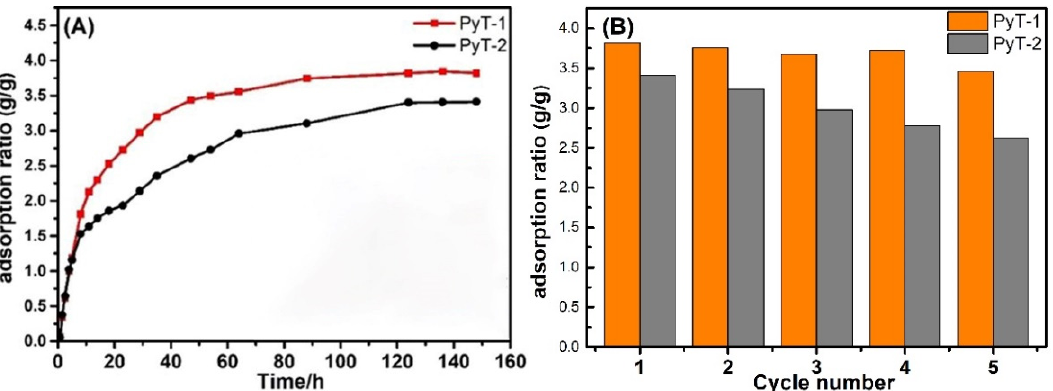
Figure 5. Iodine vapor adsorption capacities of PyT-1 and PyT-2 under 75 ℃ and ambient pressure ( A ) and adsorption capacities of PyT-1 and PyT-2 upon cycling ( B ).